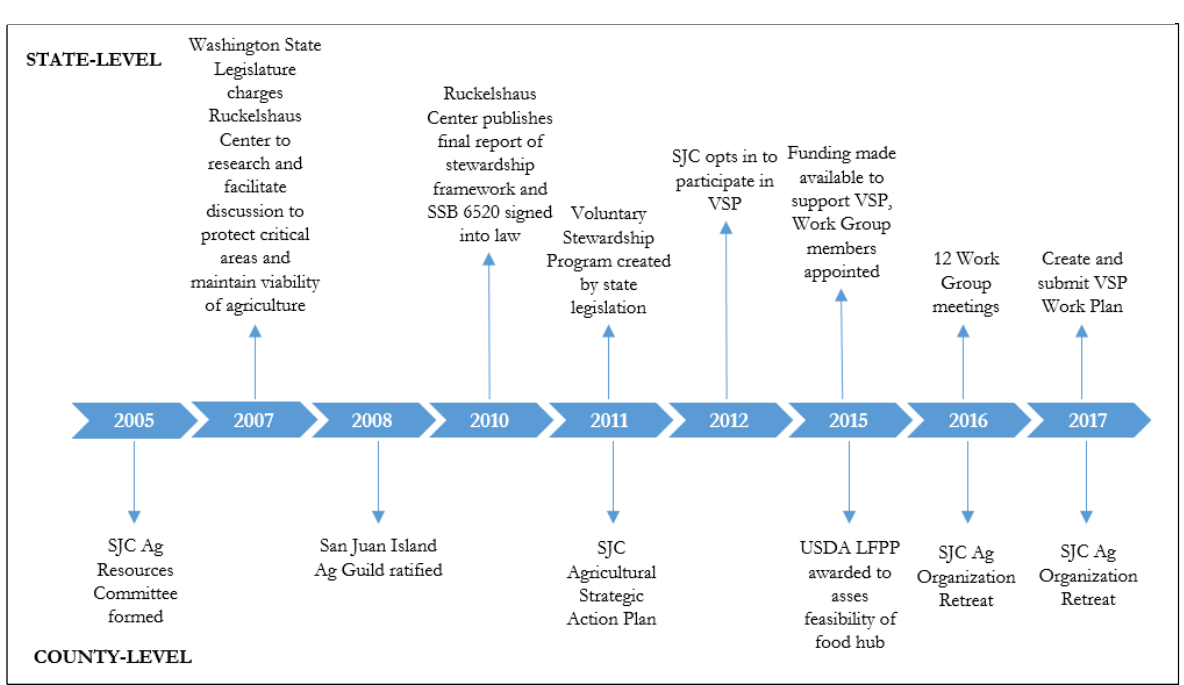
Figure 2. San Juan Count Voluntary Stewardship Program Timeline at the State and County